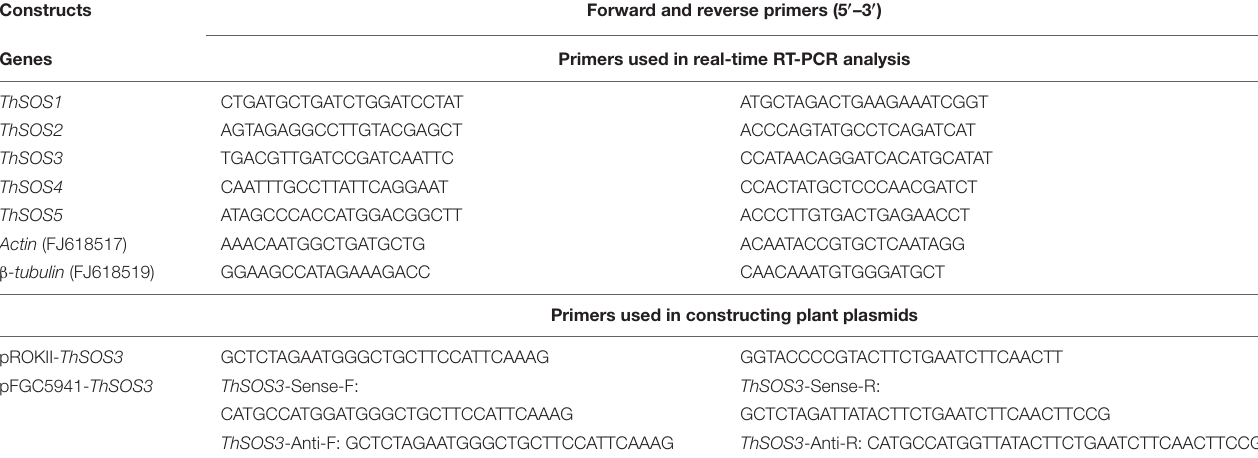
TABLE 1 | Primers sequences used in this study.